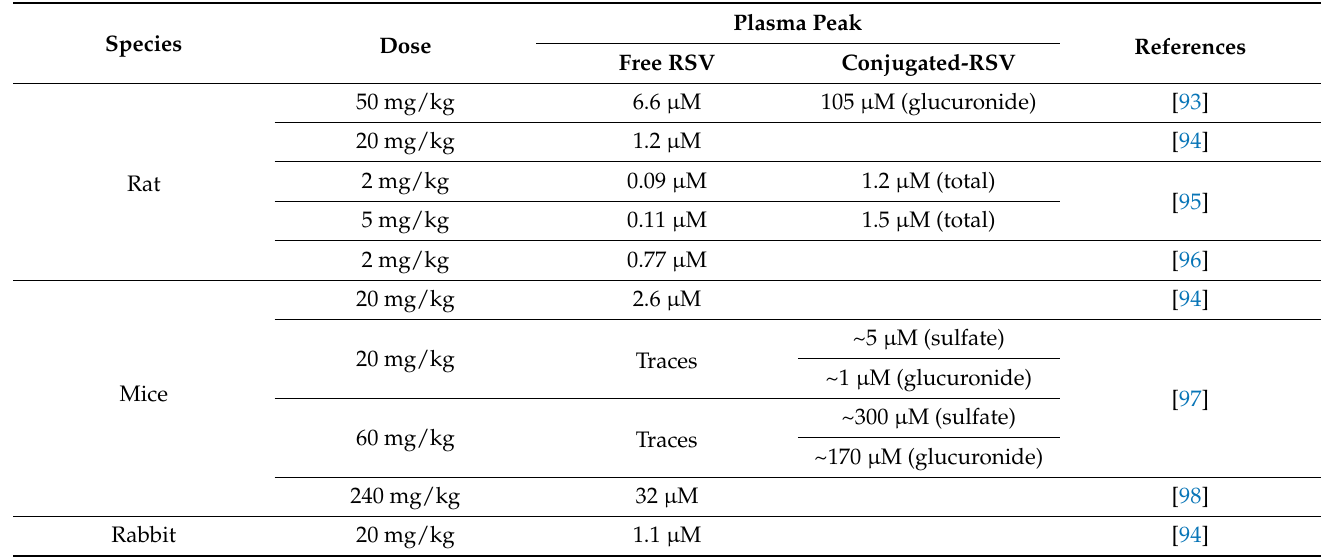
Table 1. Dosages of RSV and its metabolites in plasma after oral administration.